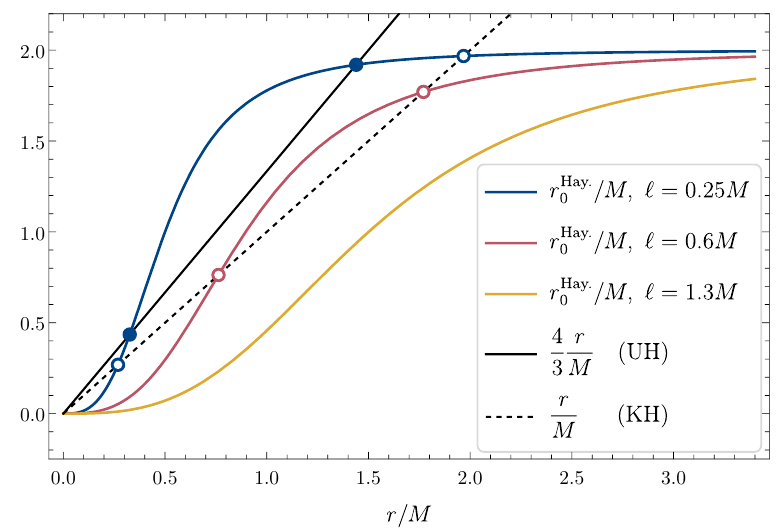
Figure 1. Plot of Hayward’s choice of r 0 ( r ) for three values of the parameter ‘ . Intersections with the straight (dashed) black line correspond to UHs (KHs) in the minimal theory α = β = 0